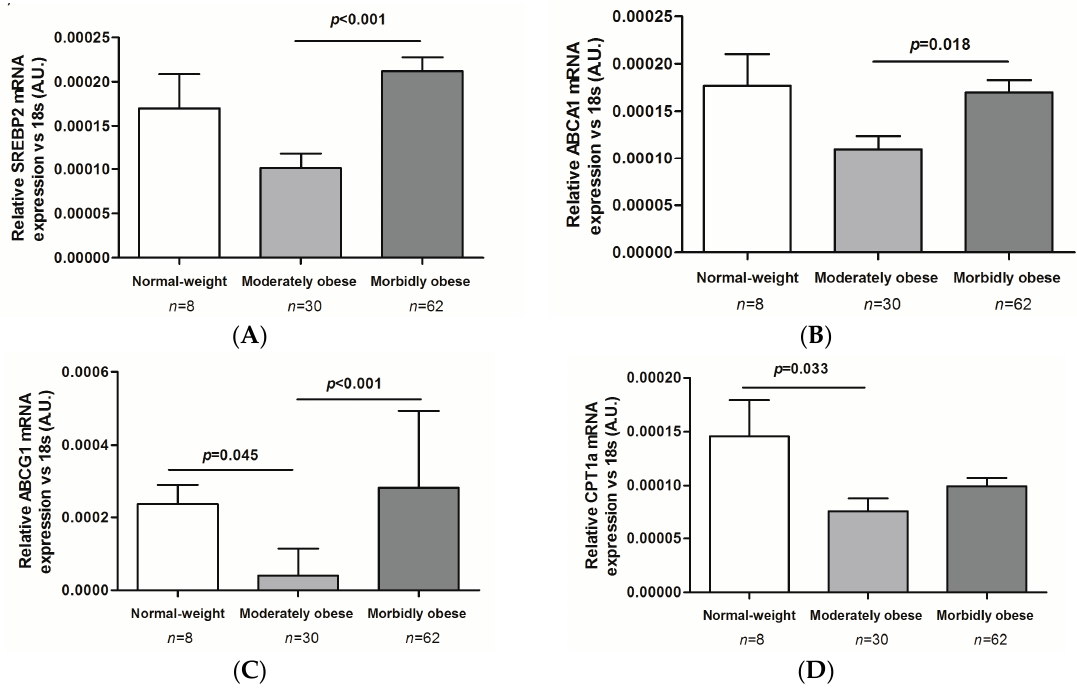
Figure 2. Liver expression of genes involved in lipoprotein secretion ( A – C ) and lipid oxidation ( D ) depending on the degree of obesity. ABCA1 , ATP binding cassette transporters A1; ABCG1 , ATP binding cassette transporters G1; CPT1 α , carnitine palmitoyltransferase 1 alpha; SREBP2 , sterol-regulatory-element-binding protein. Differences between groups were calculated using one-way ANOVA. Results are shown as the mean ± SEM. p < 0.05 is considered statistically significant.